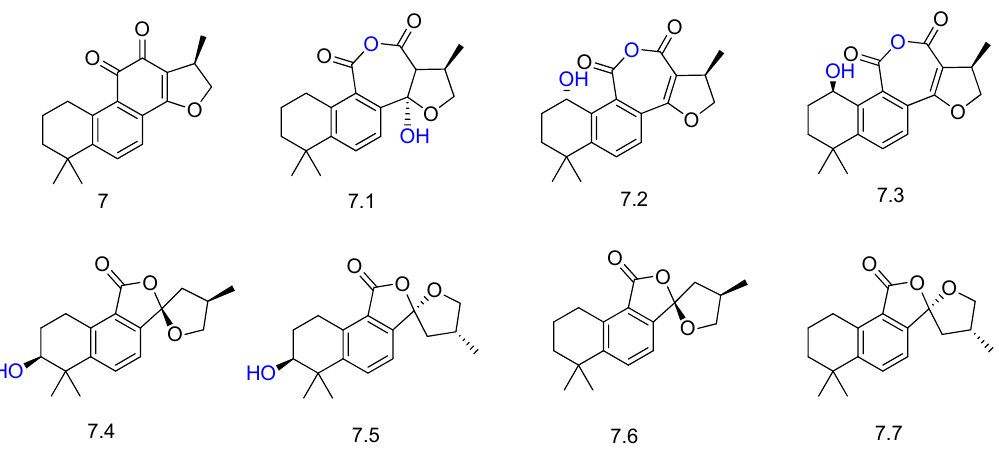
Figure 9. Derivatives 7.1 – 7.7 of cryptotanshinone ( 7 ) obtained by biotransformation with Mucor rouxii [54].